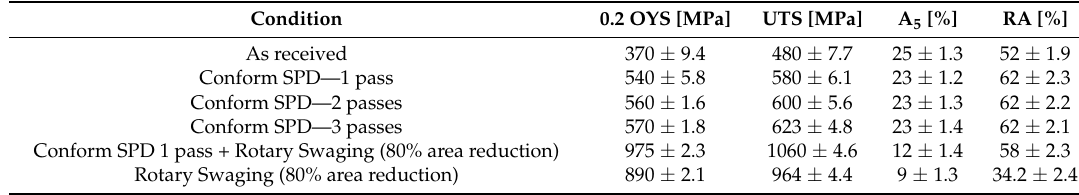
Table 3. Mechanical properties after Conform SPD processing and after Conform SPD + rotary